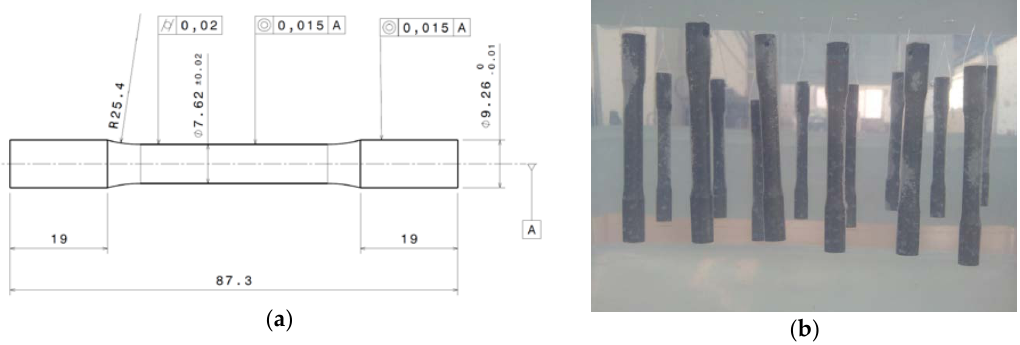
Figure 2. ( a ) Specimen dimensions according to standard UNE-EN ISO 6892-1:2016. ( b ) Set II samples during a corrosion test by immersion.